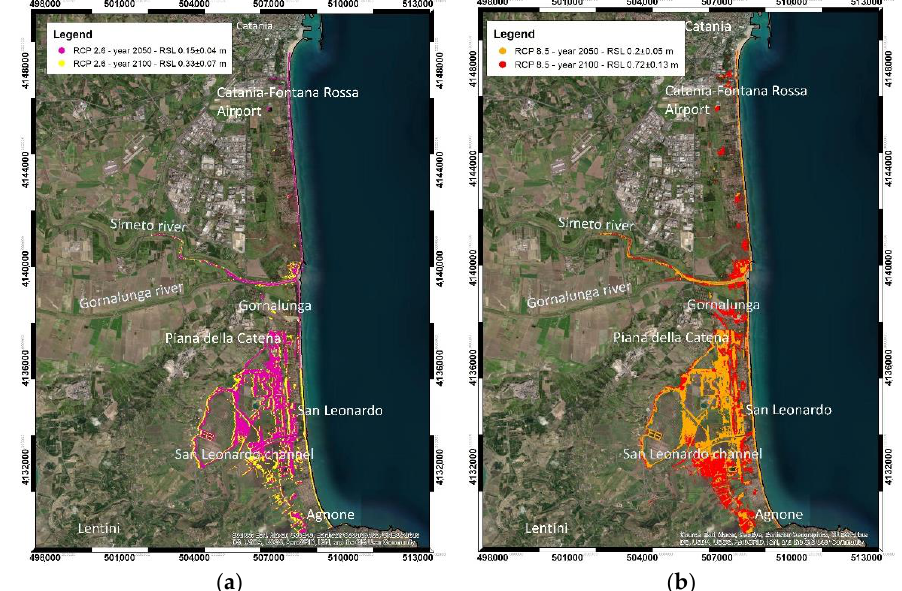
Figure 10. The Catania coastal plain. In color are reported the expected extension of flooding in 2050 and 2100 for ( a ) RCP2.6 and ( b ) RCP8.5 emission scenarios, respectively. The expected maximum loss of land in 2100 is 4.094 km 2 (high-resolution maps are inserted in Supplementary Materials Maps S2 and S3). The coastal strip is characterized by about null VLM ( − 0.7 ± 0.35 mm/year) with respect to the inner zones that show subsidence rates exceeding 10 ± 2.5 mm/year, likely due to local fluid withdrawal.